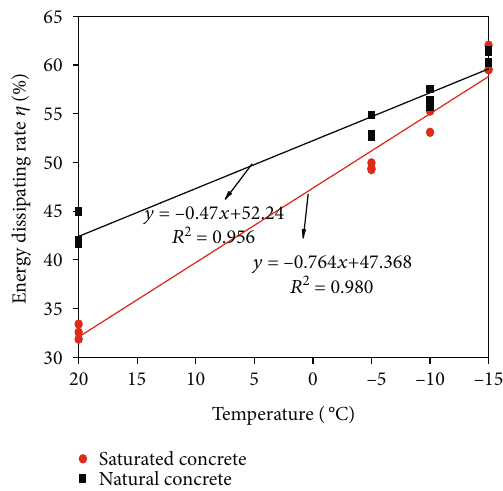
Figure 11: Relationship between energy dissipation rate of water- saturated concrete and